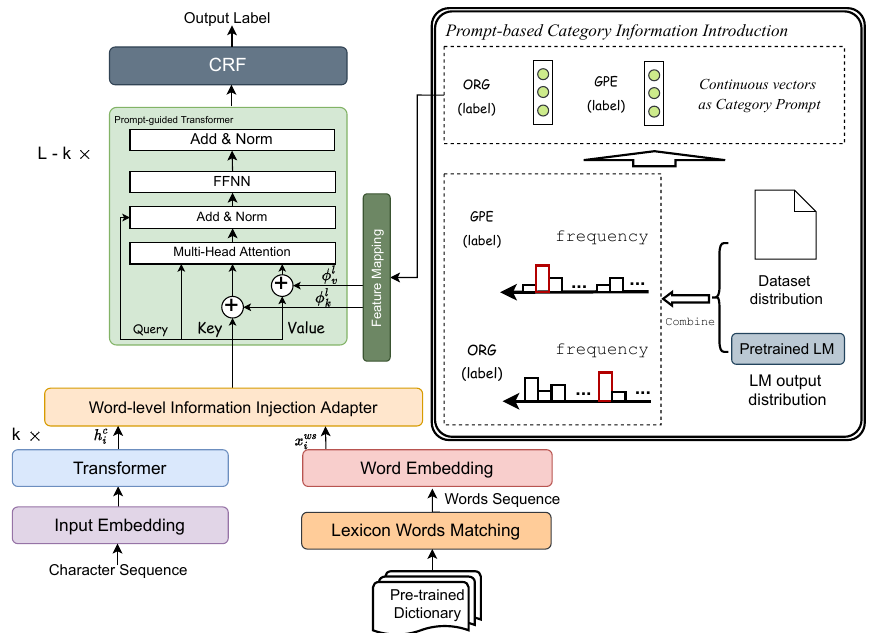
Figure 2. Structure of